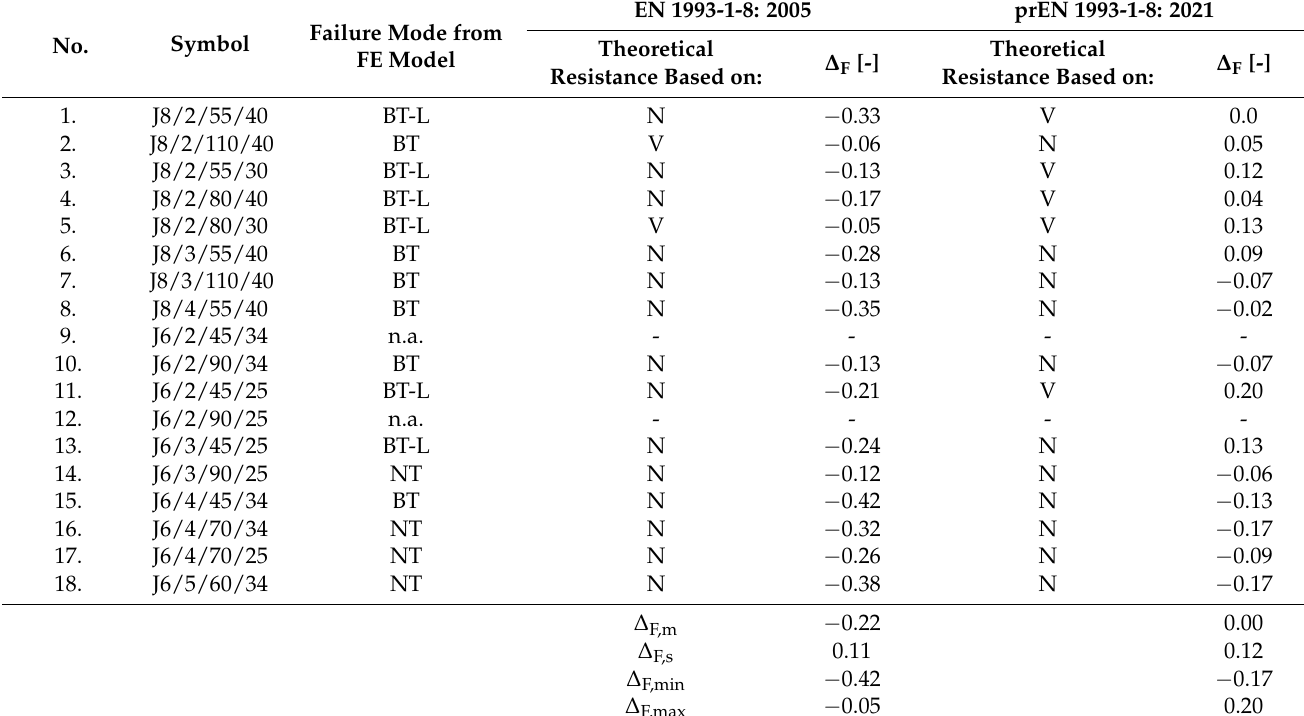
Figure 18. Comparison of relative difference ∆ F between maximum tensile load obtained from experimental tests with theoretical resistance calculated according to Eurocode 3 (version from 2005 [19] and new proposal from 2021 [36]). Table 6. Values of relative difference ∆ F between theoretical resistance F teor and experimental resistance F ult,Ex.